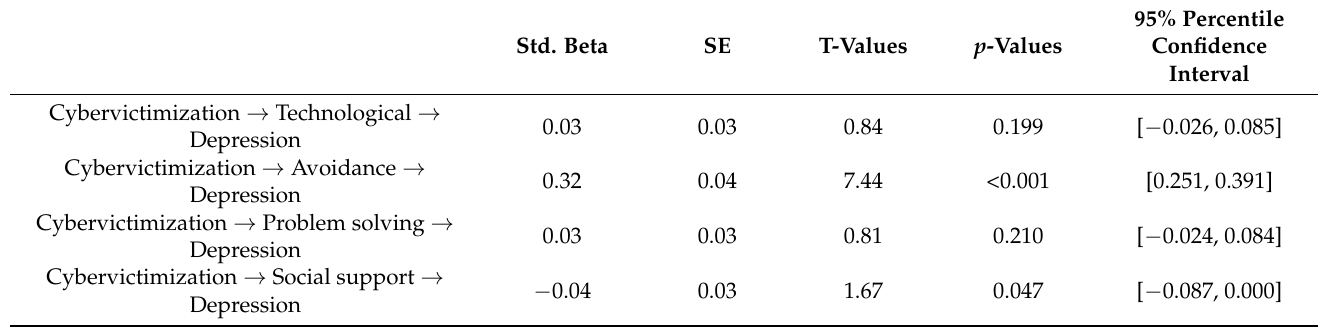
Table 4. Results of mediating